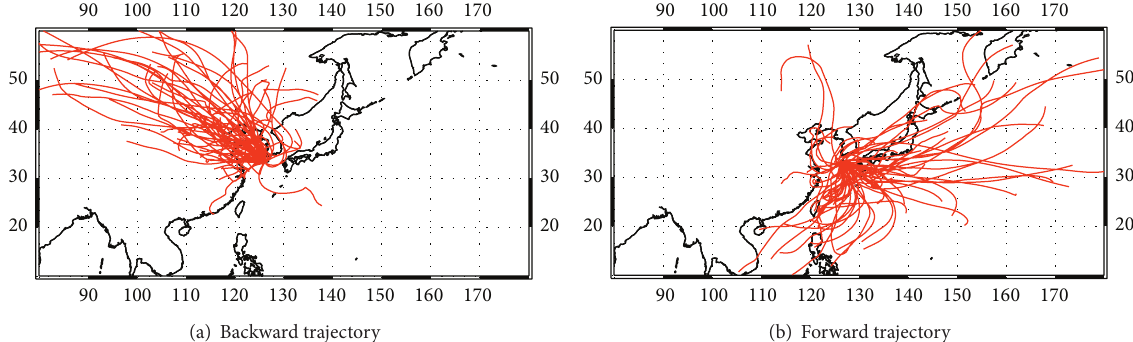
Figure 4: (a) Backward trajectories and (b) forward trajectories at 1km altitude for the cases of high concentration (HC) case.